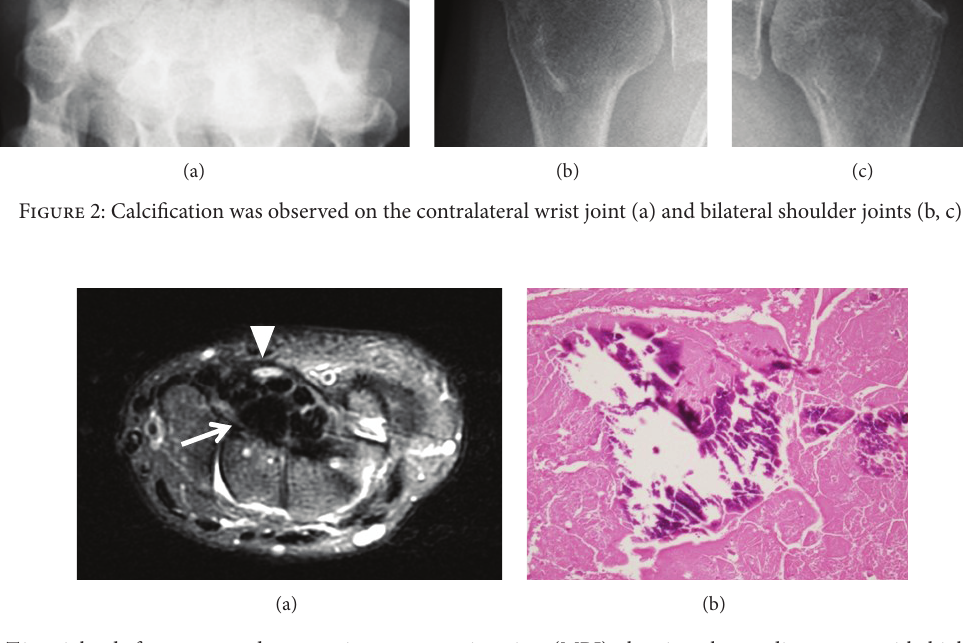
Figure 3: (a) T2-weighted, fat-suppressed, magnetic resonance imaging (MRI) showing the median nerve with high-signal intensity (arrowhead) and the mass inside the carpal tunnel (arrow). (b) Microscopic appearance of the excised calcified